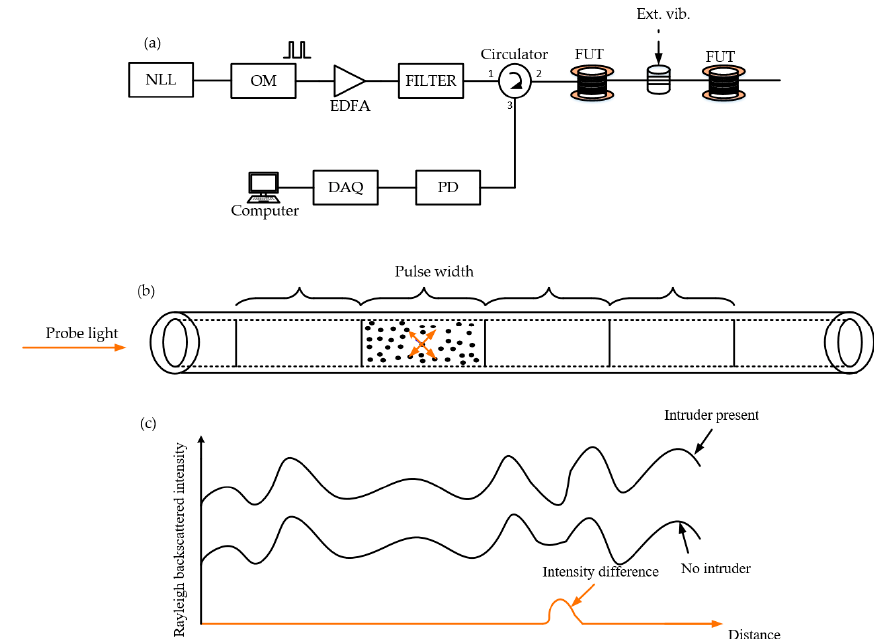
Figure 1. ( a ) Setup of a Φ -OTDR system, ( b ) illustration of Rayleigh phenomenon, ( c ) intrusion detection. NLL: narrow line-width laser, OM: optical modulator, EDFA: erbium-doped fiber amplifier, DAQ: data acquisition card, PD: photo ‐ detector.